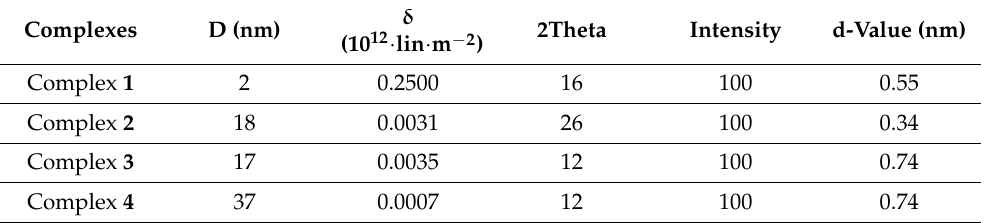
Table 3. Data on crystallite diameters (D), dislocation density ( δ ), 2, intensities, and d-spacing of pip complexes 1 – 4 were acquired using